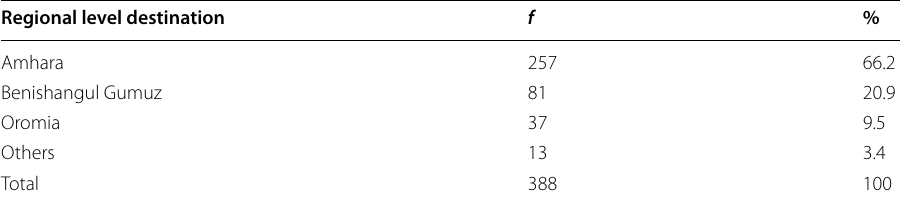
Table 3 Regional level destinations of migrants during their last migration. Source : Own Household Survey